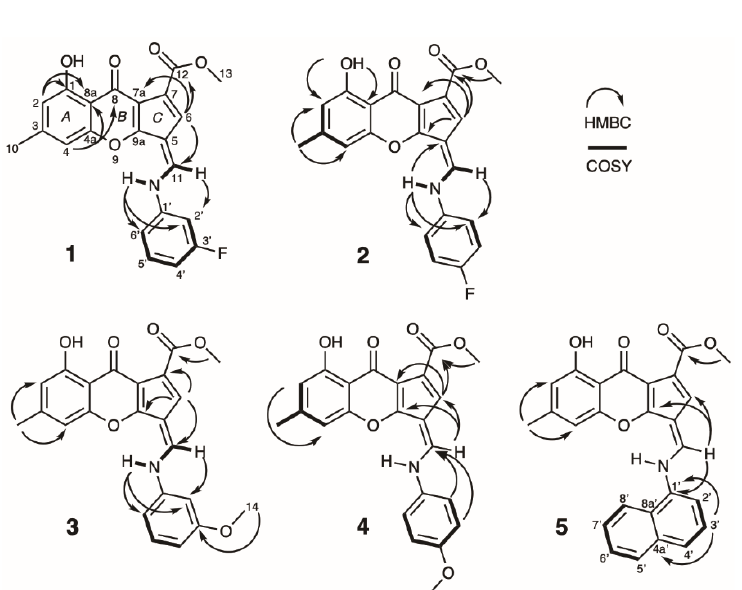
Figure 3. Chemical structures of new chalanilines 1 – 5 with selected 2D NMR correlations. 4-Fluoro chalaniline A ( 2 ) was isolated as a yellow amorphous solid and the HRESIMS provided an m / z value of 394.1088 [M + H] + (calcd for C 22 H 17 FNO 5 , 394.1085; ∆ ppm = 0.8) and m / z value of 416.0909 [M + Na] + for the sodium adduct (calcd for C 22 H 16 FNO 5 Na, 416.0905; Δ ppm = 1.0). The 1 H NMR spectrum of 2 was very similar to the spectrum of 1 , the only differences can be found in the number of aromatic signals and the coupling and integration pattern for the fluoro-benzene moiety. Two sets of aromatic signals, with each an integration of ~2H, supported the symmetric, para -substituted fluoro-aniline incorporation (Table 1). The 13 C spectrum showed twenty signals: one methyl, one methoxy, two carbonyl, one phenolic, and fifteen olefinic carbons. Only two aromatic protons and carbons could be found due to the symmetry in the 4 ′ -fluoro aniline moiety. 1 J C-F coupling could be found for C-4 ′ (244.8 Hz), 2 J C-F coupling of 23.0 Hz for C-3 ′ /5 ′ , 3 J C-F coupling of 8.3 Hz for C 2 ′ /6 ′ , and 4 J C-F coupling (2.6 Hz) for C-1 ′ (Table 1). Two-dimensional NMR experiments were analyzed to complete the structure suggestion for 2 , with key HMBC correlations from N-H to both the fulvene (C-5) and the 4-fluoro anilino ring C-2 ′ /6 ′ , and also from the H-11 to C-2 ′ (Figure 3). Table 1. 1 H and 13 C NMR spectroscopic data for compounds 1 – 5 (all recorded in DMSO- d 6 ), a J HH in Hz, b J CF , c J HF , * partially assigned from 1D data. 1